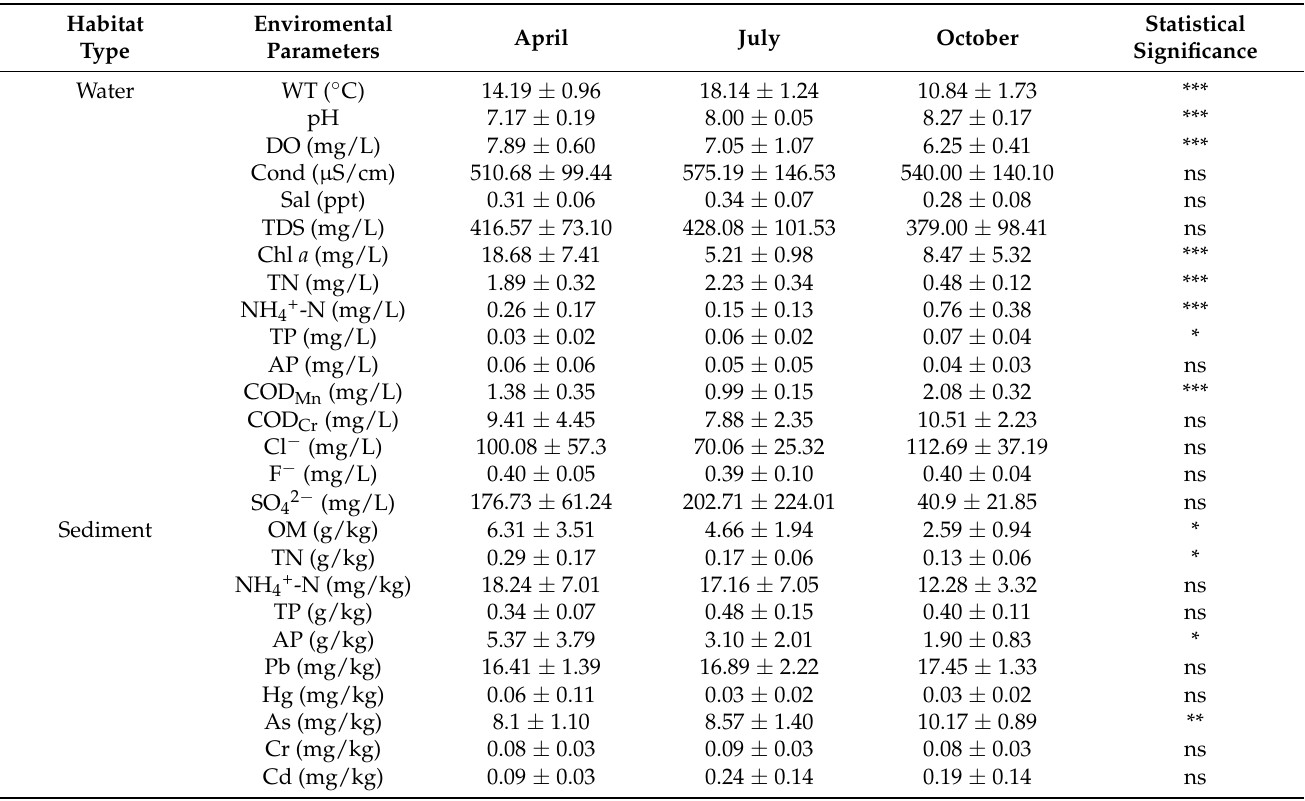
Table 1. Water environment parameters (mean ± SD) of the Taiyangshan wetland in different sampling periods.